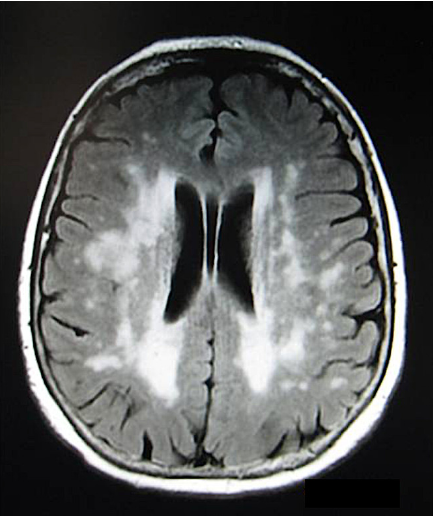
Figure 18. MRI encephalic scan showing typical Gadolinium diffusion due to encephalic vasculitis in patient from Figure 17.